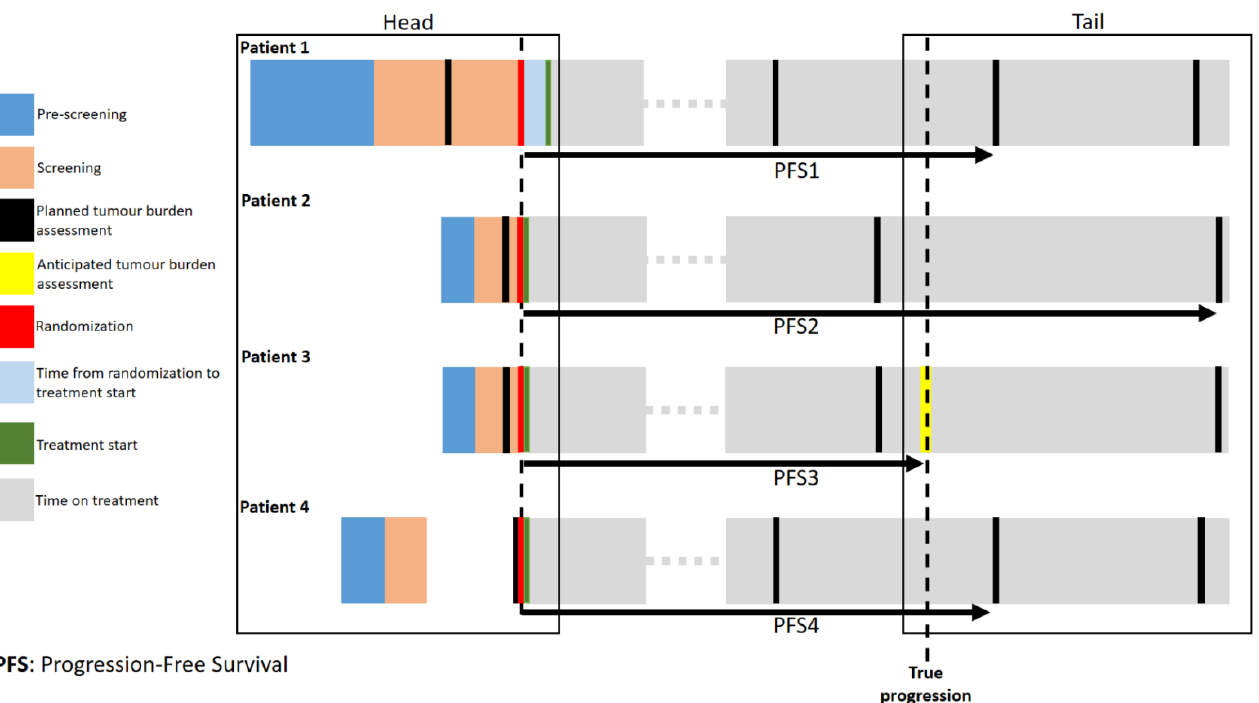
Figure 1. Description of “border time” bias frame -times.